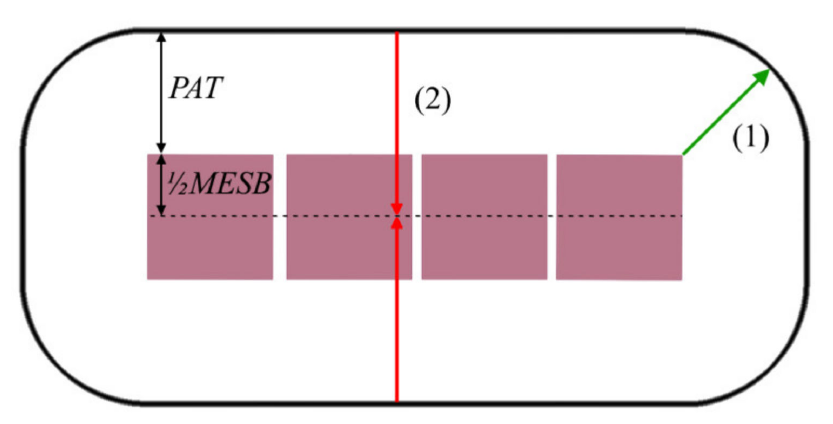
Figure 2. The sizes of forward (1) and inward (2) buffers to detect the linear patterns in the case of perfectly aligned buildings.